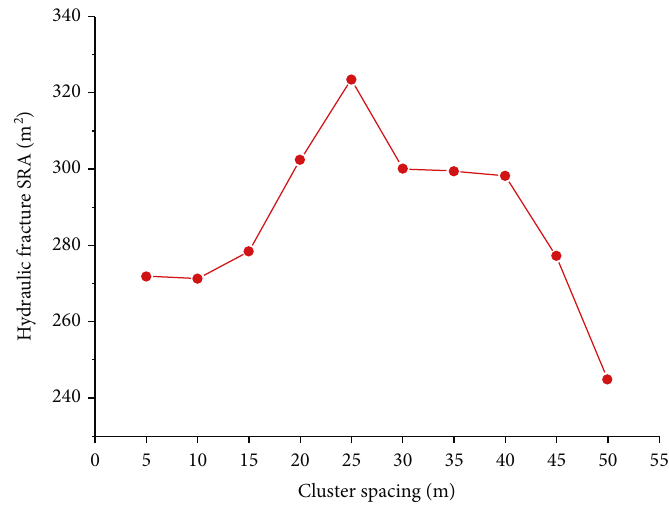
Figure 10: Variation of hydraulic fracture SRA with cluster